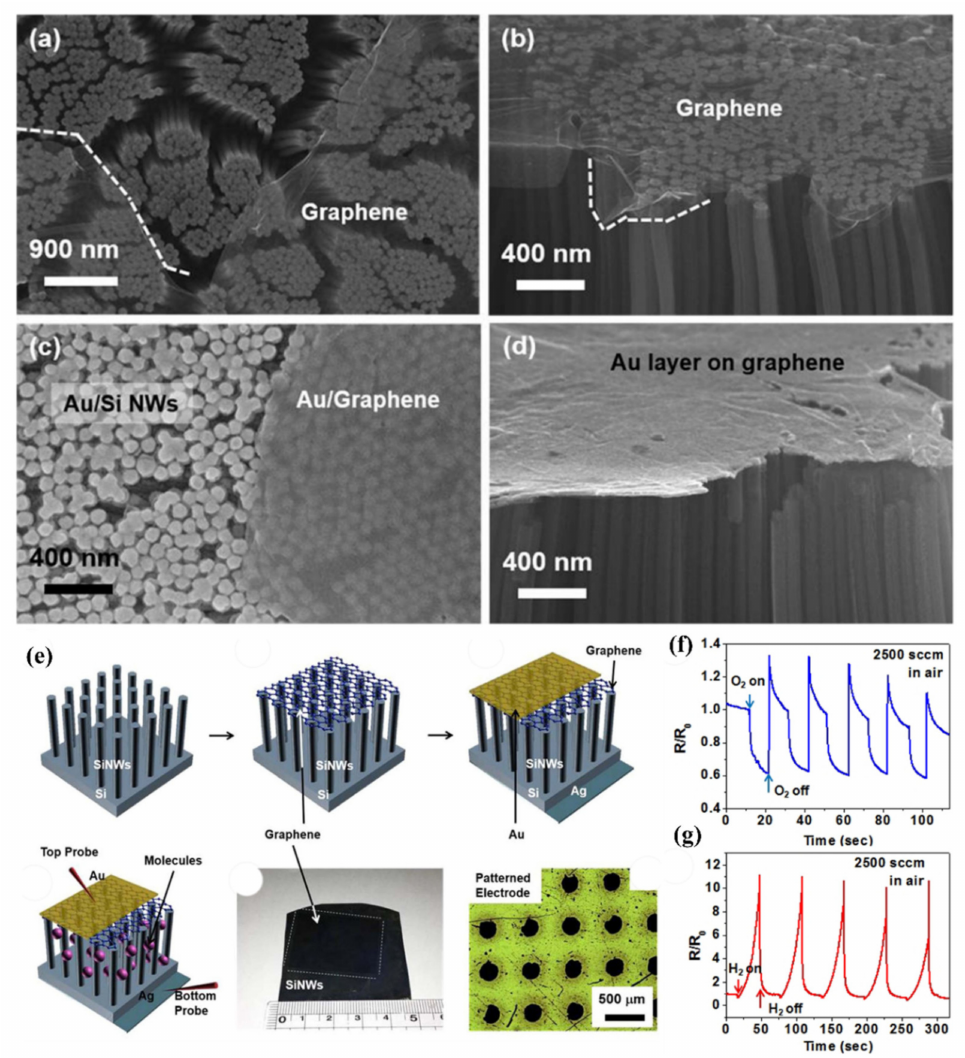
Figure 28. Plan-view image of the graphene / Si-NW heterostructure where, ( a ) dark graphene sheet on tips of SiNWs, ( b ) tilted-view image of graphene / Si NWs confirming the uniform contact between graphene and Si NWs, and ( c ) plan-view image of an Au film on graphene and tips of Si NWs. A continuous Au film is formed only on graphene where ( d ) tilted-view image of Au / graphene / Si NWs with a continuous Au film is well placed on the graphene / Si NWs, ( e ) fabrication process of the device. Normalized resistance responses of graphene / SiNW heterostructure molecular sensor under repeated exposures of ( f ) O 2 and ( g ) H 2 gases in air at room temperature. Exposure intervals of O 2 and H 2 gases are 10 s and 30 s, respectively. Reproduced from